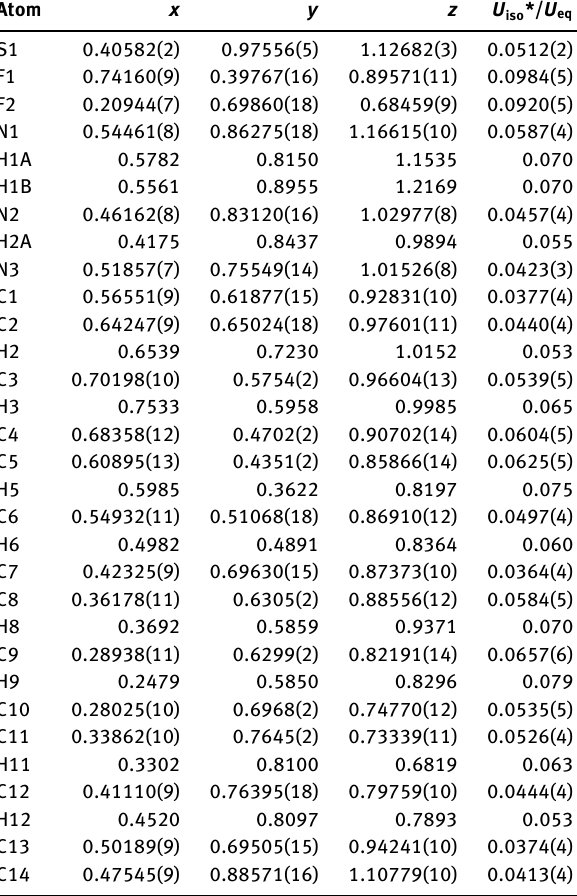
Table 2: Fractional atomic coordinates and isotropic or equivalent isotropic displacement parameters (Å 2